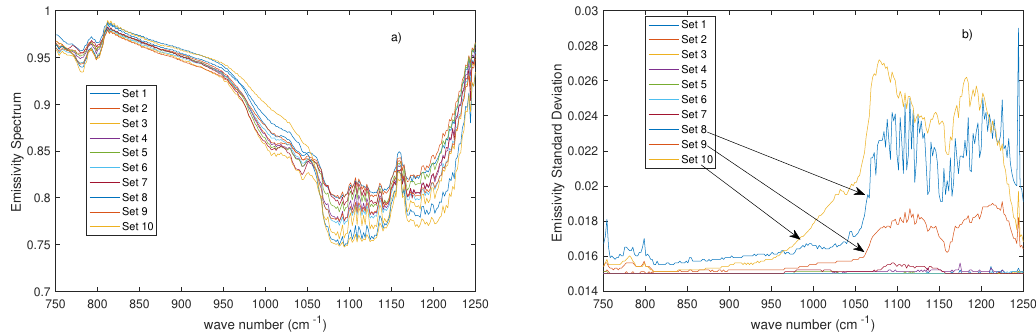
Figure 4. ( a ) Mean emissivity of the ten sets of in situ measurements. ( b ) Standard